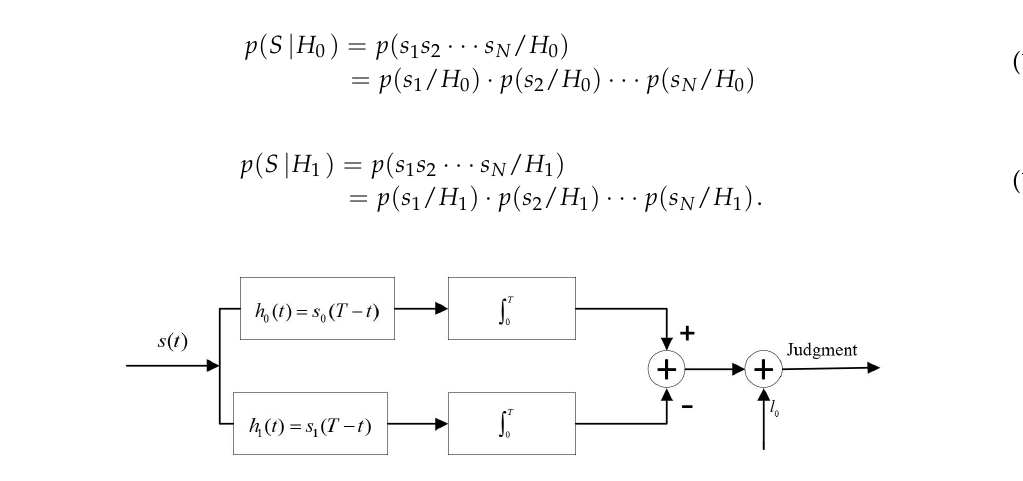
Figure 4. Binary hypothesis model of target detection using BeiDou reflected